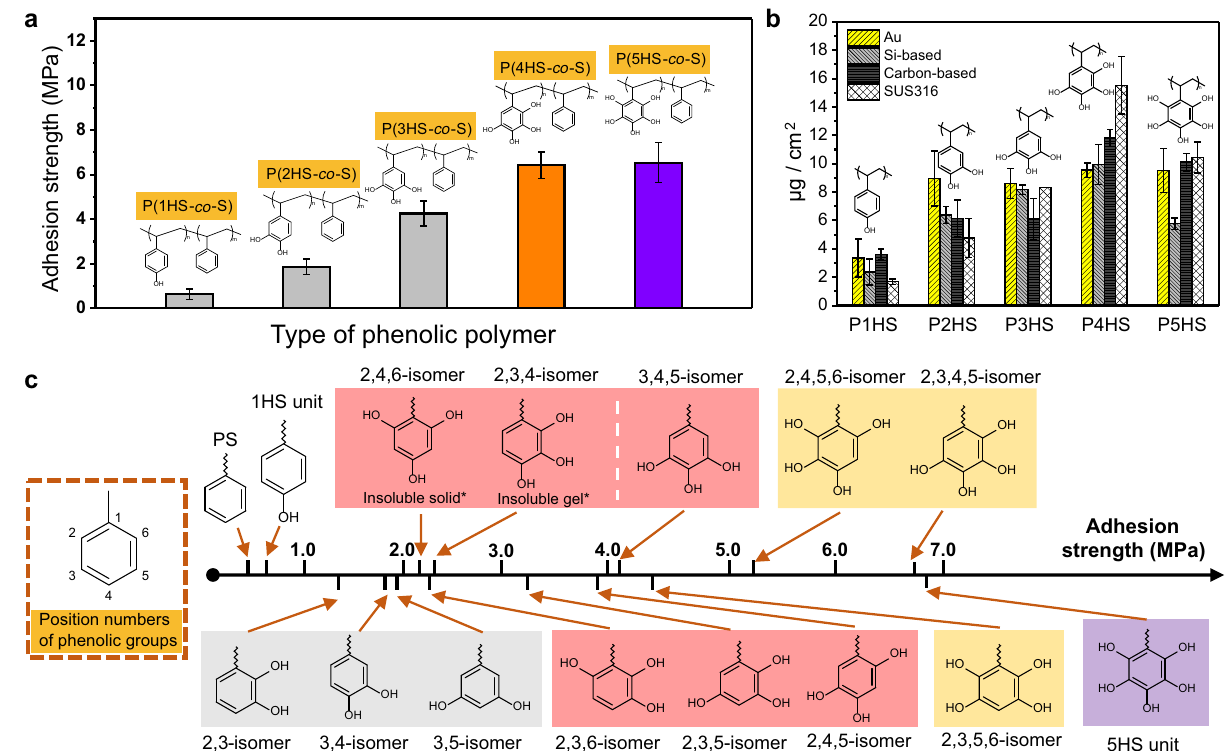
Fig. 2 Underwater adhesion of phenolic polymers with various phenol-substitution patterns. a Adhesion strengths of P(1HS -co -S) to P(5HS -co -S) with ~10% of phenolic units at their optimized M n (~80 kDa). The results represent the mean ± s.d. ( n = 5). b Adsorbed quantities of phenolic homopolymers on various QCM chips. The results represent the mean ± s.d. ( n = 5). c Adhesion strength of phenolic copolymers with de fi ned numbers and positions of hydroxyl groups. *For, 2,4,6- and 2,3,4-isomers, the copolymers with 2.5% phenolic content were tested because the copolymers with 10% phenolic content were